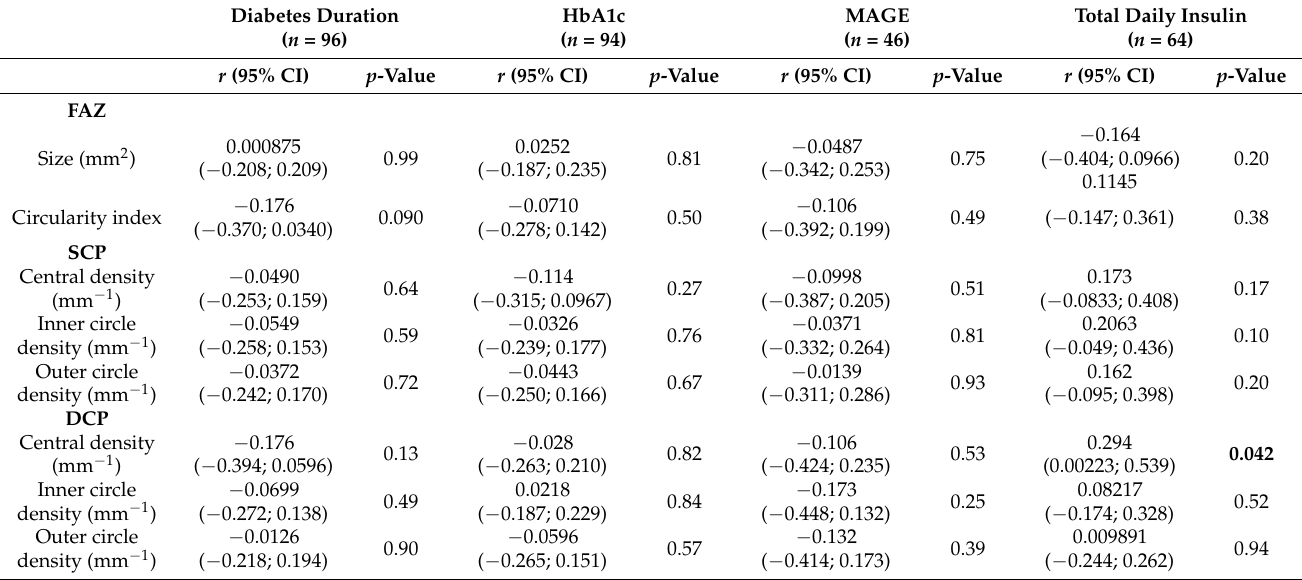
Table 3. Association between retinal vascular parameters and diabetes characteristics.